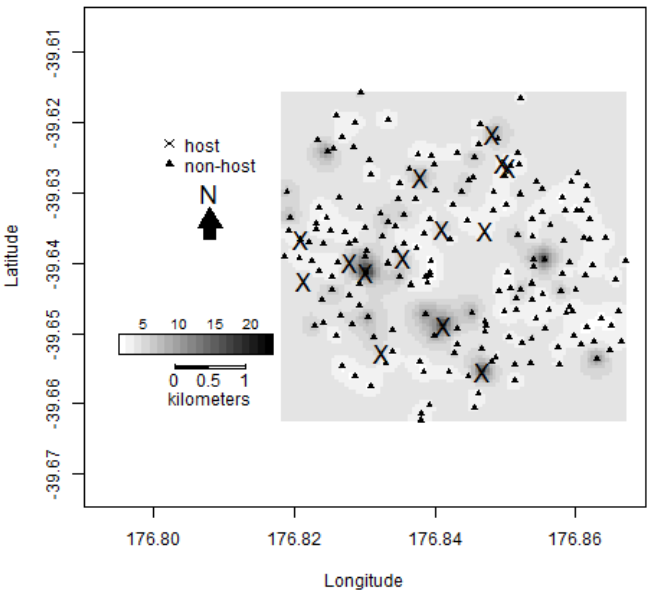
Figure 6. Spatial interpolation of male codling moth ( Cydia pomonella ) trap catches showing the estimated trap catch of a location, with the darker regions showing higher estimated catches within Hastings. The crosses signify the locations of traps in host trees ( n = 15) and the triangles signify the locations of traps in non-host trees ( n = 185).